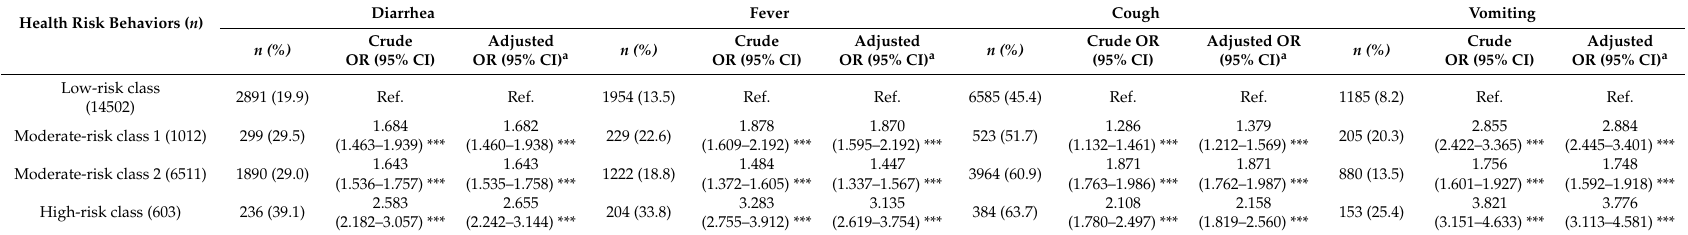
Table 3. Association of physical disorders with di ff erent latent classes of